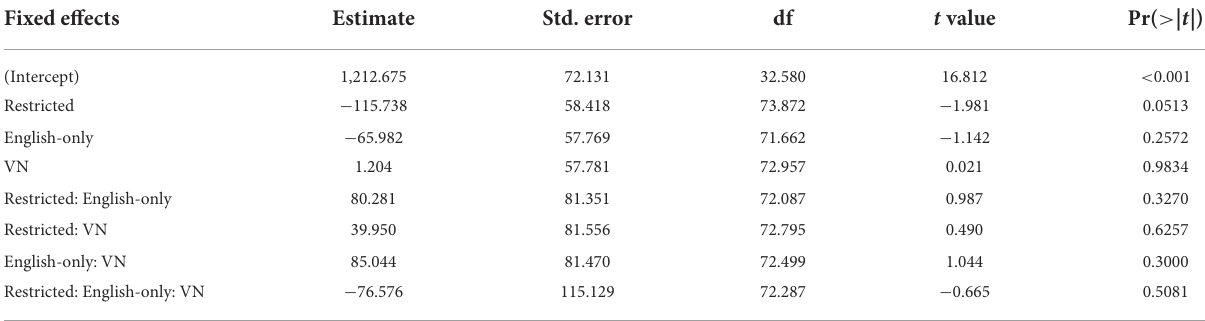
TABLE 3 RT results of a mixed model comparing L1-L2 congruency for type and restriction (congruent, AN, and free as reference categories) for NSs.